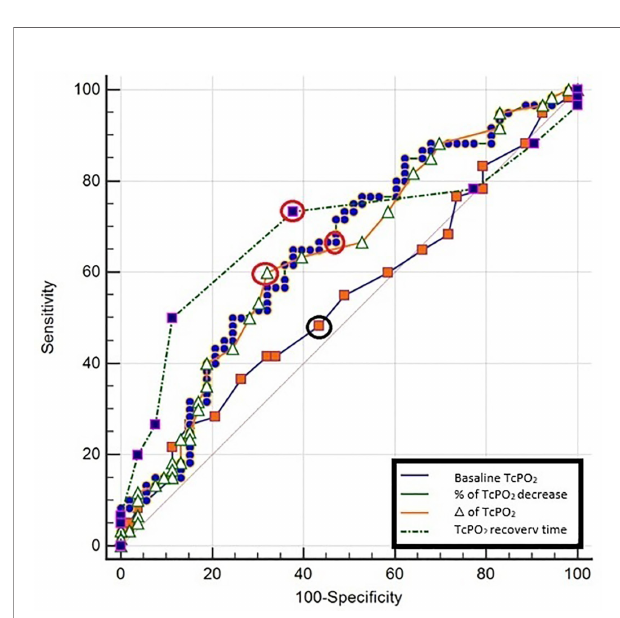
FIGURE 4 | Sensitivity and speci fi city of individual macrovascular assessment in relation to monophasic arterial fl ow supplying the relevant angiosome. ABI, ankle-brachial index; DPA, dorsalis pedis artery; PTA, posterior tibial artery; TBI, toe-brachial index; p, signi fi cance; CI, con fi dence interval; mm, Hg-millimetres of mercury; the highest sensitivity and speci fi city for individual measurements are highlighted in bold circles.